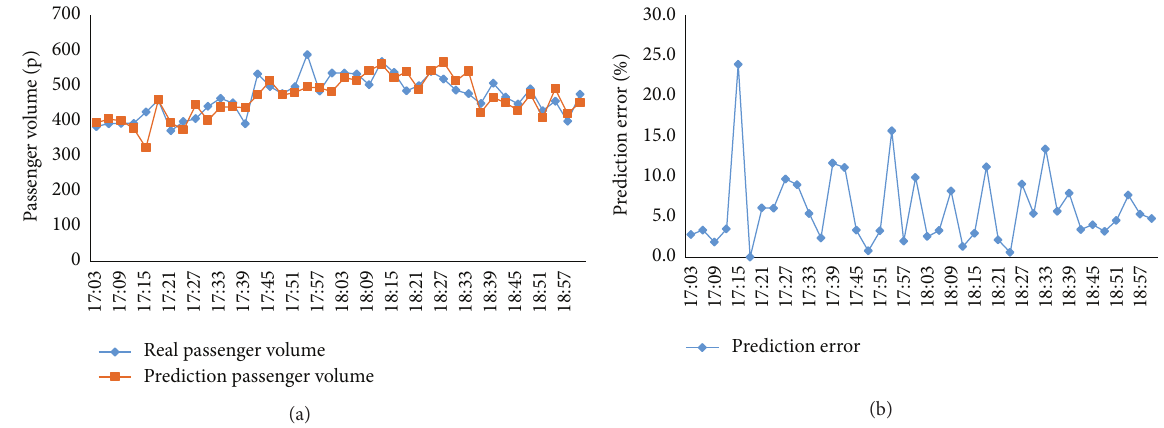
Figure 8: Forecasting the result for each 3 minutes in evening peak hour using nonparametric